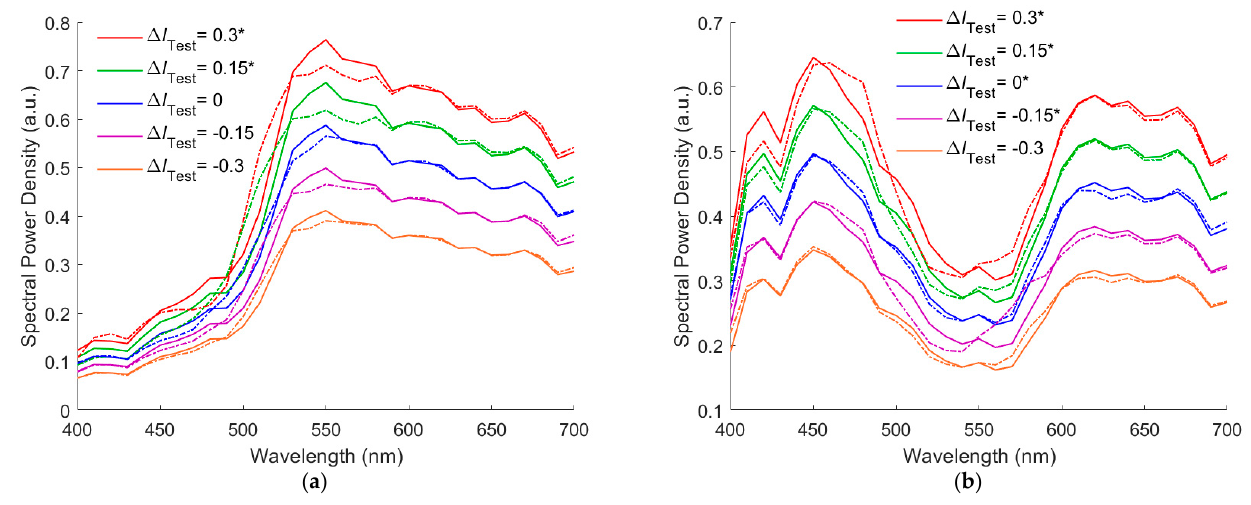
Figure 7. ( a ) Target spectrum S Reflection (solid line) and the reconstructed spectra S Rec (dashed line) for the cases with the irradiance deviation Δ I Test = − 0.3, − 0.15, 0, 0.15, and 0.3, where the RGBF camera and the ID-LUT method are used. The test sample is prepared using the 5Y 8.5/8 color chip. ( b ) The same as ( a ) except that the color chip is 10P 7/8. Outside sample are indicated with “*” in the legend.